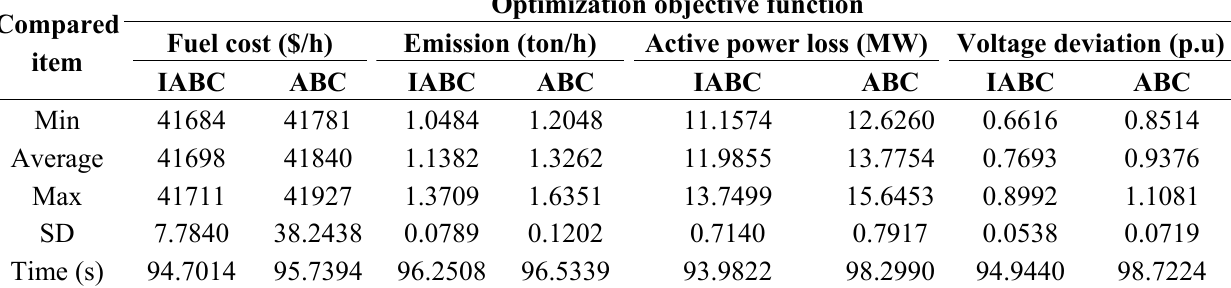
Table 7. Results obtained by the IABC and ABC algorithms for different single objective OPF for the IEEE 57-bus system.